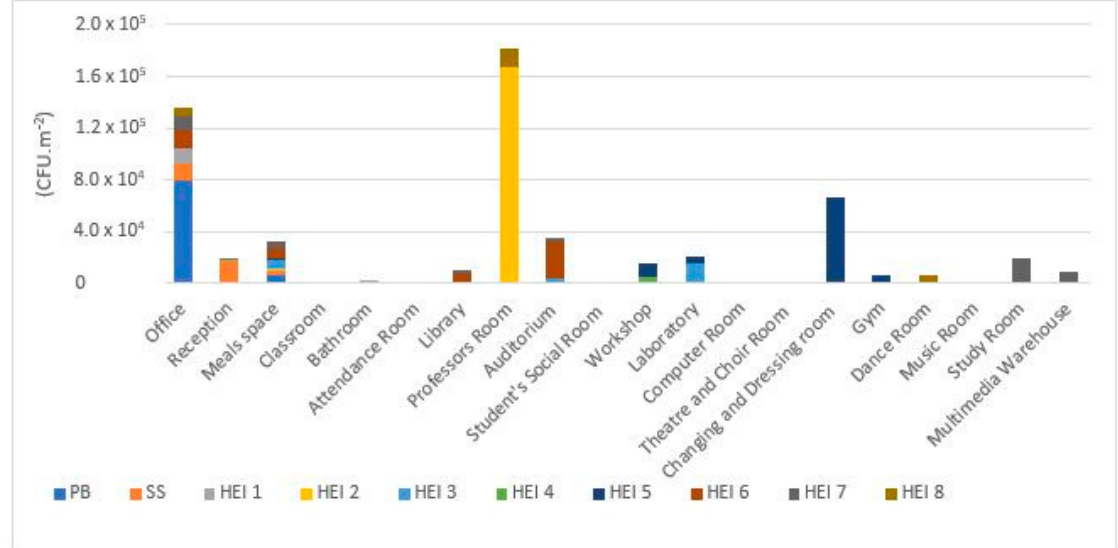
Figure 4. Fungal contamination in surface swabs on MEA.